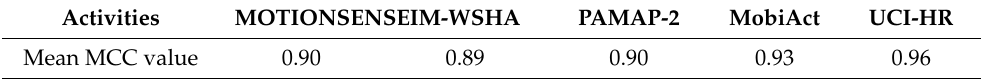
Table 7. Cohen’s kappa and Matthews correlation coefficient from all datasets.